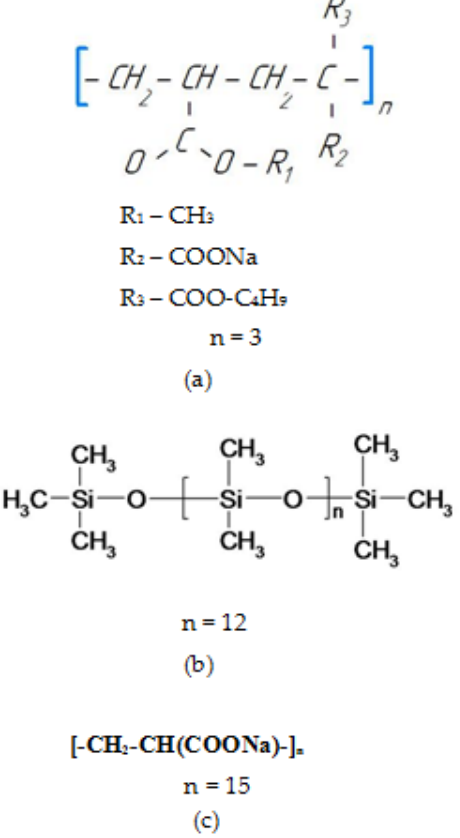
Figure 1. Formulas of materials used: ( a ) acrylic varnish, ( b ) PC, ( c ) NaPA.